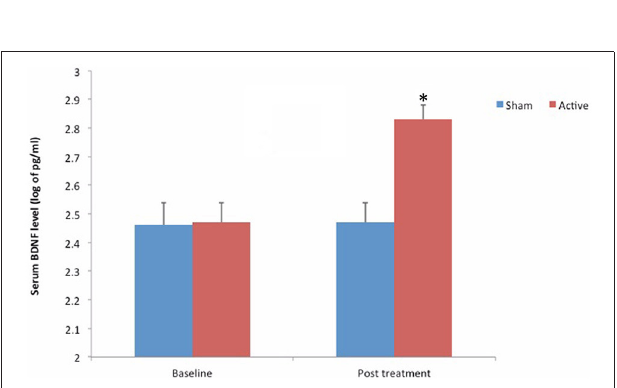
FIGURE 2 | Pain VAS scores at baseline and during the treatment. The error bars indicate the standard error of the mean (SEM). Asterisks ( * ) positioned above the symbols indicate significant differences ( p < 0.01 ) at those time points using Anova model type III test.